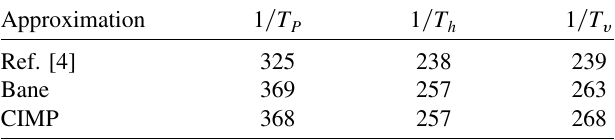
INTRABEAM SCATTERING FORMULAS FOR HIGH . . TABLE IV. Comparison of the Bane and CIMP high energy approximations to the more complete theory of Ref. [4] for the ATF prototype damping ring without betatron coupling and with an rms vertical dispersion of 6.6 mm. Quantities are in sec (cid:10) 1 . Approximation